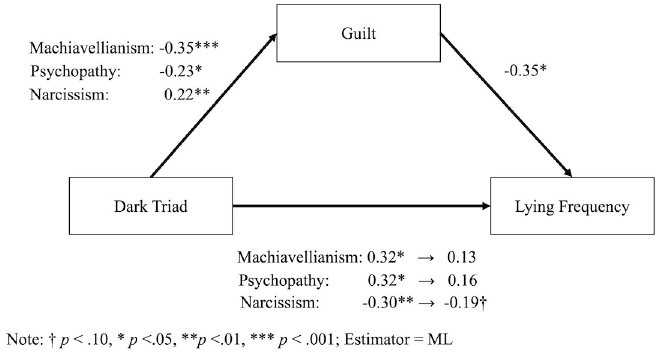
Fig 4. Models of the generalized SEM for mediation